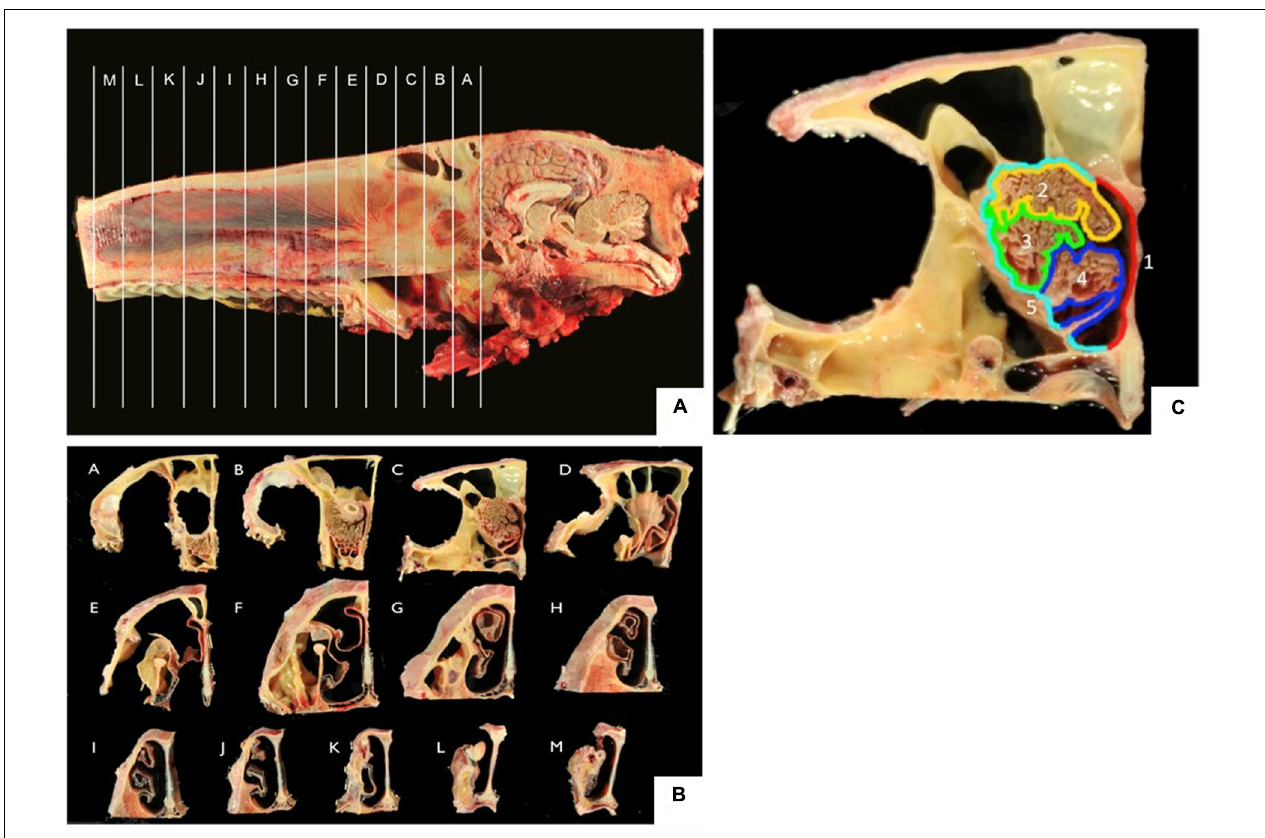
FIGURE 1 | (A,B) Frontal sections A–M of the equine nose, beginning at the most caudal parts of the ethmoid bone (section A) and ending at the nares (section M); (C) five localizations for sampling including nasal septum (1, red), dorsal (2, yellow), mid (3, green), ventral (4, blue) part of the nasal turbinate, lining of the nasal cavity (5,